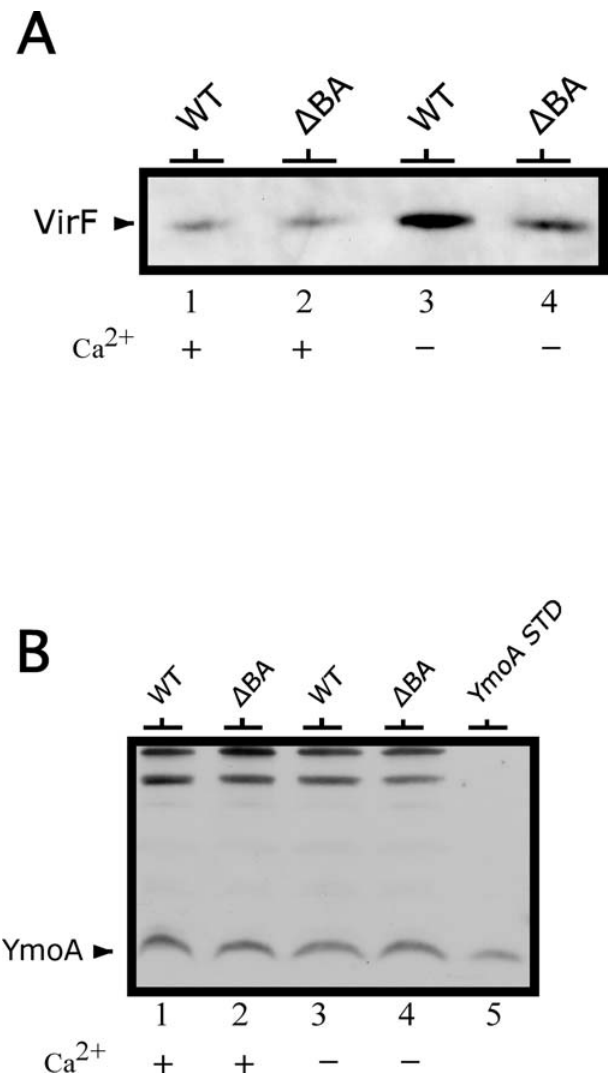
Figure 9. Affect of smpB-ssrA Mutation on VirF and YmoA Protein Levels Cultures of wild-type (WT) or D BA strains of Y. pseudotuberculosis were grown in secretion non-permissive (lanes 1 and 2) or permissive medium (lanes 3 and 4) at 37 8 C for 3.5 h as described in Materials and Methods. Bacteria were harvested and analyzed for VirF (A) and YmoA (B) proteins by Western blot analysis using specific polyclonal antibodies. Purified YmoA protein was used as a control (lane 5). DOI: